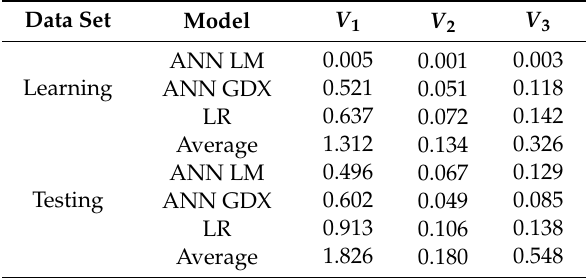
Table 1. A comparison of root mean square errors (RMSEs) for estimation models. Data Set Model V 1 V